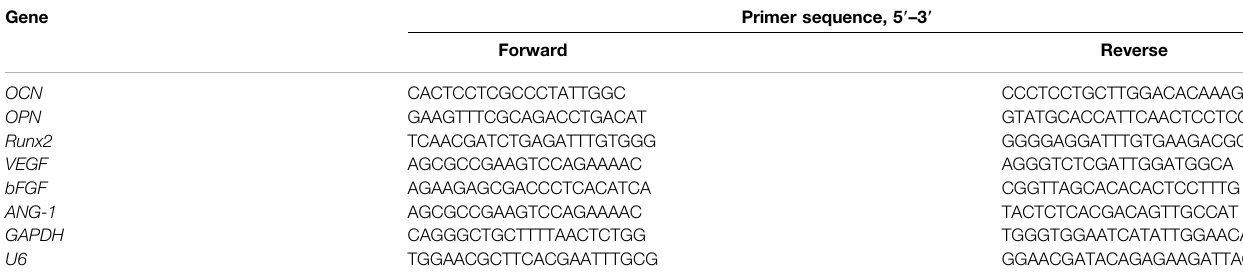
TABLE 1 | List of primers